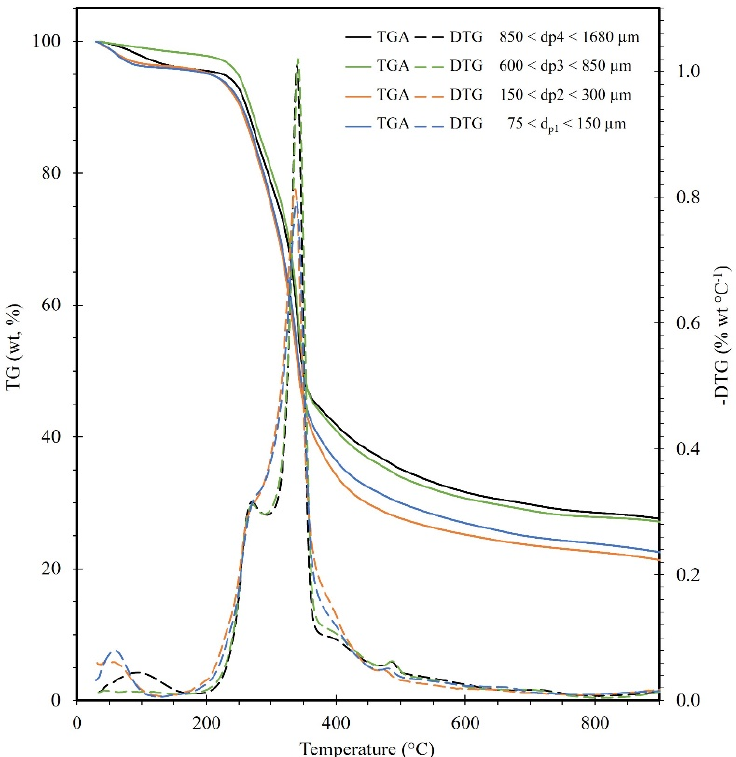
Figure 1. TGA and DTG curves for the pyrolysis of BCS at 5 °C/min and different particle sizes.